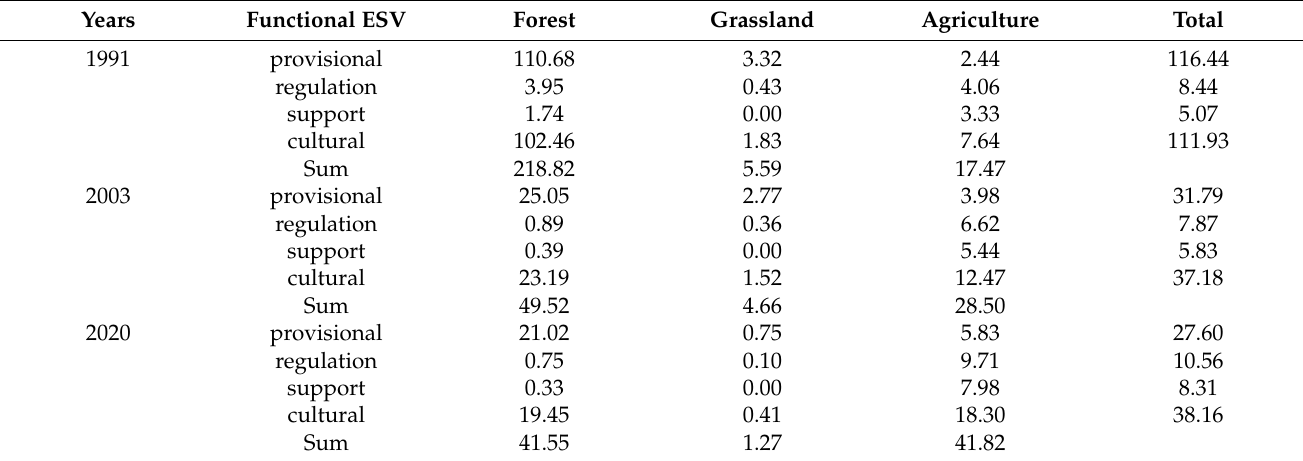
Table 8. Major functional units of ESs and LULC